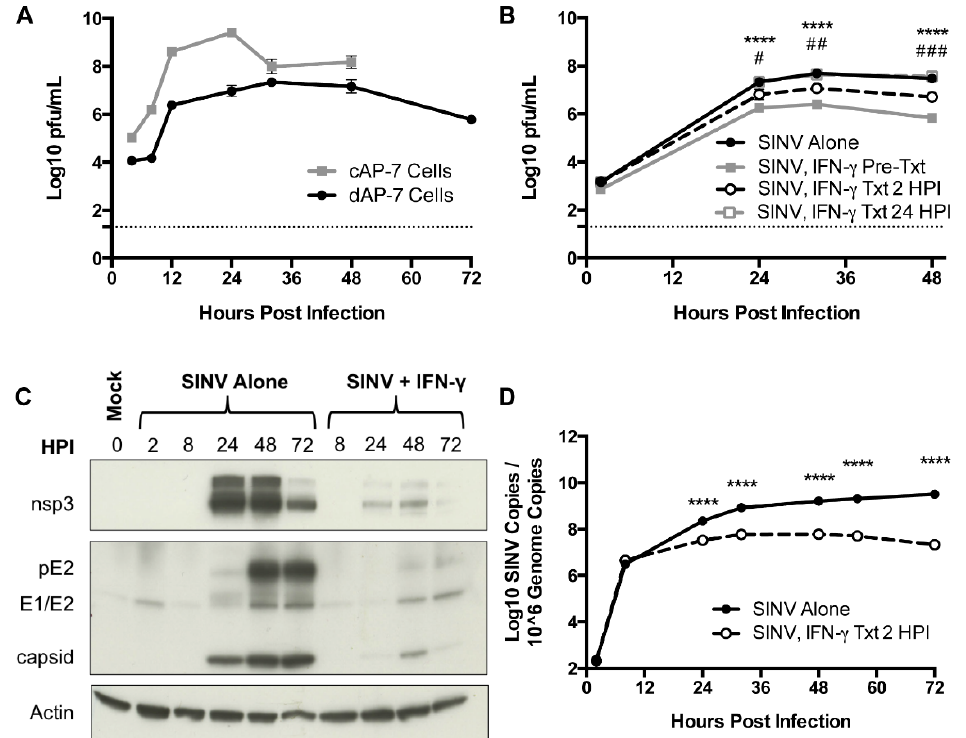
Figure 1. SINV replication in neurons in vitro and the effect of IFN- γ. ( A ) Infectious virus was measured by plaque assay after infection of cAP-7 (gray line) and dAP-7 (black line) cells infected with SINV TE at a MOI of 5. ( B ) dAP-7 cells were infected with SINV TE at a MOI of 1 and treated with 500 U/mL IFN- γ 2 h prior to infection (gray square and solid line; SINV, IFN - γ Pre -Txt), at 2 HPI (white circle and black dashed line; SINV, IFN- γ Txt 2 HPI), at 24 HPI (white square and gray dashed line; SINV, INF- γ Txt 24 HPI) or untreated (black circle and solid line; SINV Alone) ( n = 3 replicates per cell type per treatment group; data are representative of two ( A ) or three ( B ) independent experiments and are presented as the mean ± SEM; dashed line indicates level of detection; **** p < 0.0001, SINV Alone vs. SINV, IFN- γ Pre -Txt; # p < 0.05, ## p < 0.01, ### p < 0.001, SINV Alone vs. SINV, IFN- γ Txt 2 HPI by Tukey’s multiple comparisons test). ( C , D ) dAP-7 cells were infected with SINV at a MOI of 1 and either left untreated or treated with 500 U/mL IFN- γ at 2 HPI. ( C ) Nonstructural (nsp3) and structural (pE2, E1/E2, capsid) SINV protein production was evaluated by western blot using β actin as control. ( D ) Viral RNA levels were evaluated by qPCR in untreated (black circle and solid line) and IFN- γ -treated (white circle and black dashed line) dAP-7 cells ( n = 3 replicates per treatment group; data are representative of two independent experiments and are presented as the mean ± SEM; **** p < 0.0001, by Bonferroni’s multiple comparisons test).